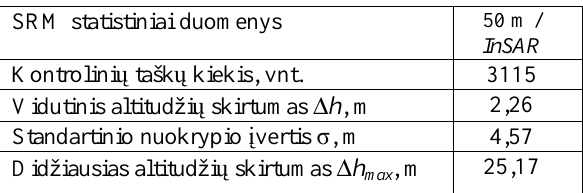
Table 2. Accuracy data of DTM SRM statistiniai duomenys 50 m /